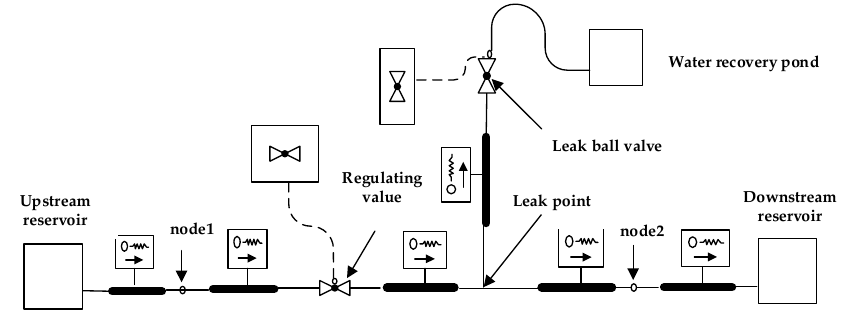
Figure 3. Pipeline modeling by Flowmaster.